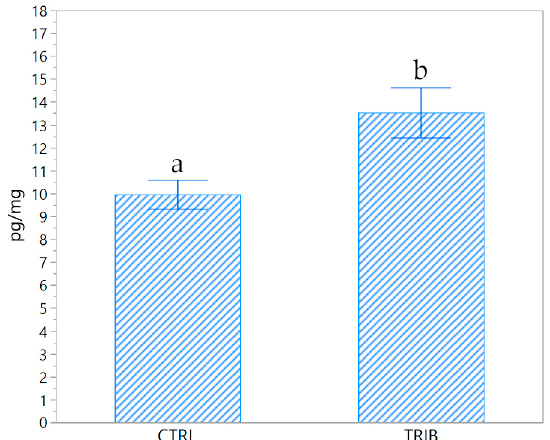
Figure 2. Hair cortisol concentrations (pg / mg) in the control group (CTRL) and in the group of piglets fed a diet supplemented with 0.2% tributyrin (TRIB). Data are presented as the mean a,b: significant di ff erences between groups ( p =